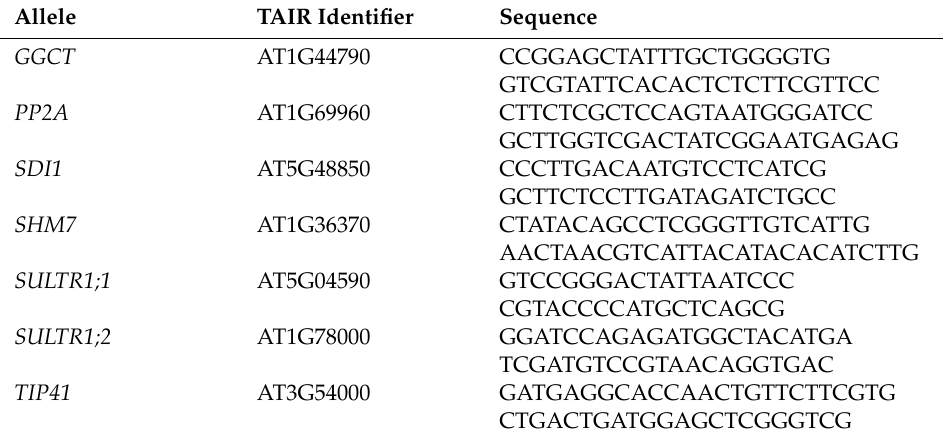
Table A3. Primers used to assess abundance of genuine sulfur-responsive